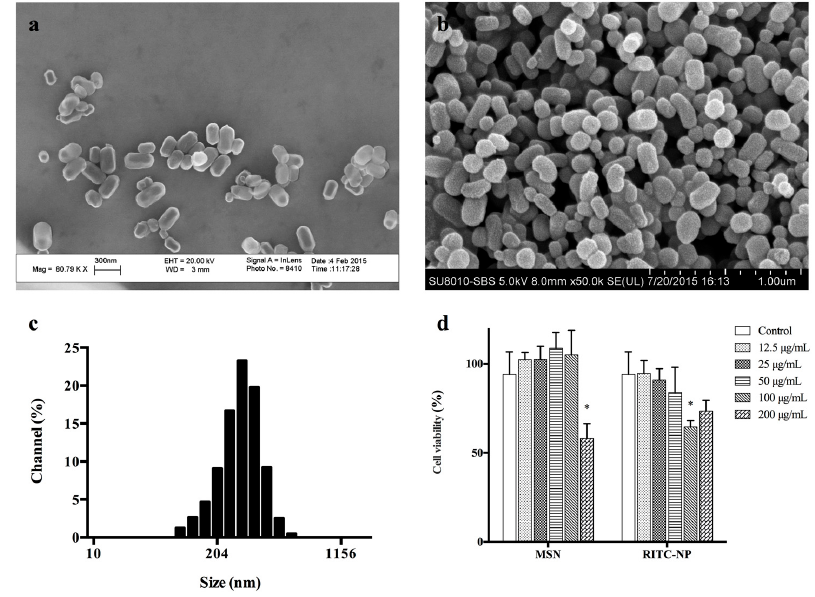
Figure 1. Field emission scanning electron microscope (FE ‐ SEM) images of the mesoporous silica nanoparticles (MSNs) ( a ) and synthesized fluorescent mesoporous silica nanoparticles (RITC ‐ NPs) ( b ), and the size distribution of RITC ‐ NPs analyzed by dynamic light scattering (DLS) ( c ). The viability of human gingival epithelial cells (hGECs) after 24 h treatment with various concentrations of MSNs and RITC ‐ NPs was assessed using the Cell Counting Kit ‐ 8 (CCK ‐ 8) by measuring the absorbance (450 nm) of the supernatant ( d ). Three independent experiments were undertaken in triplicate. The asterisk (*) indicates the significant difference ( p < 0.05) between the control and treatment groups.